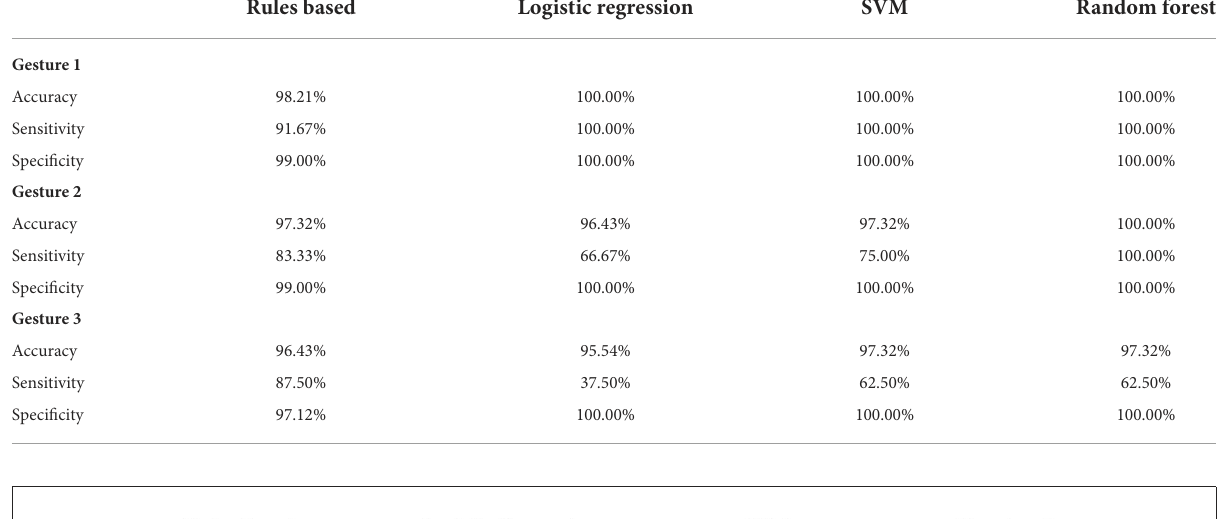
TABLE 4 Performance of all classification models.